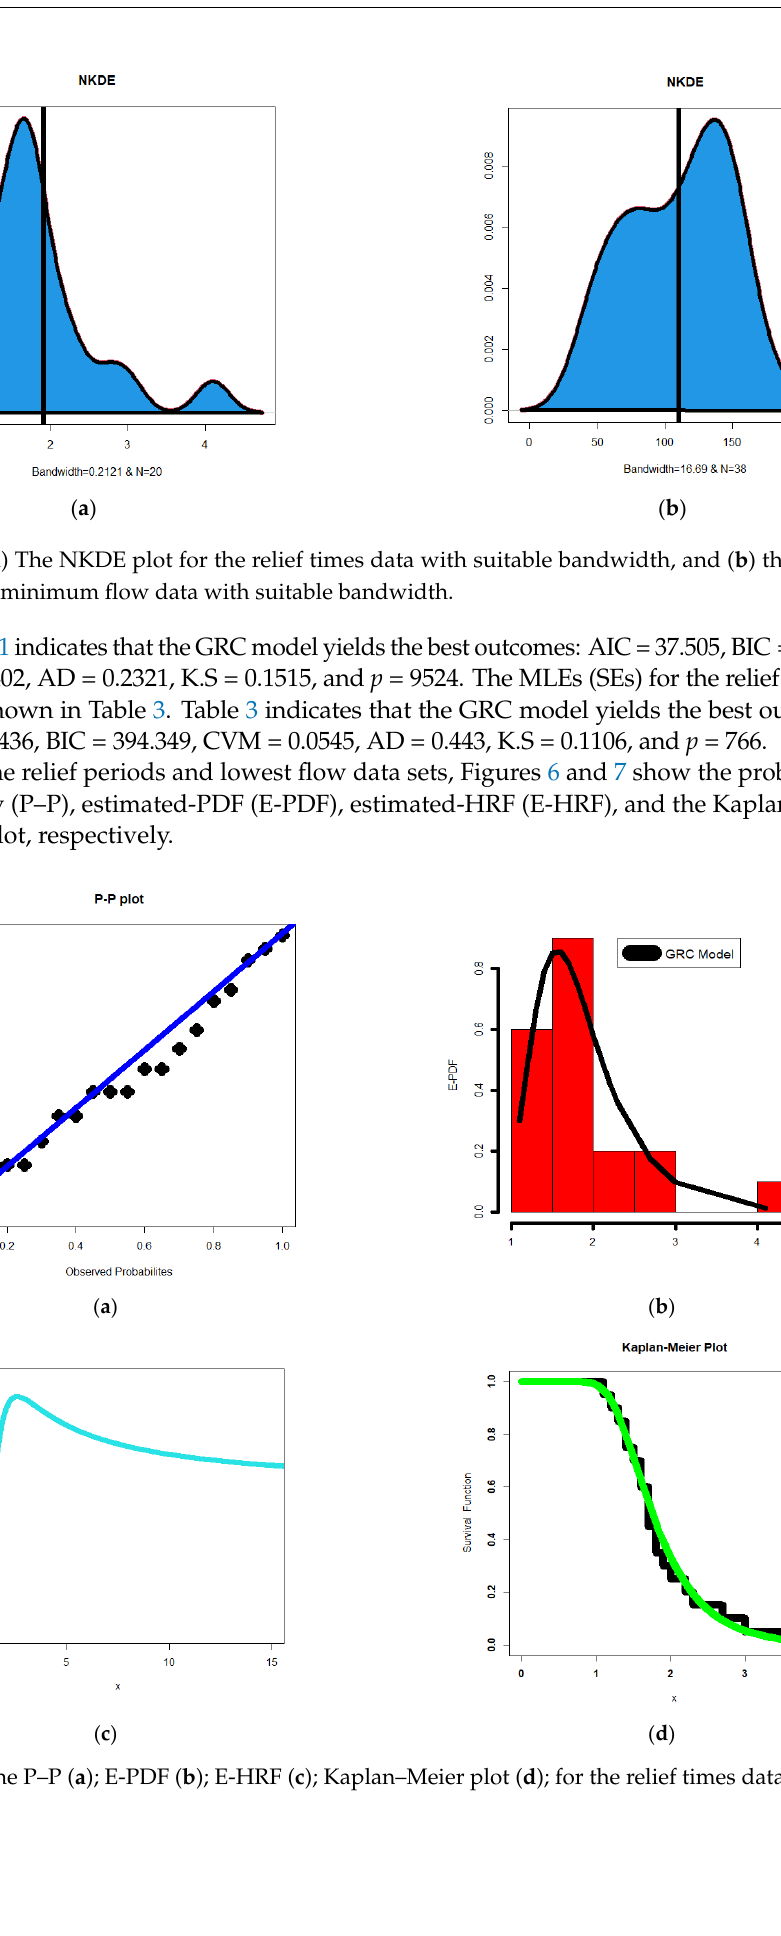
Figure 4. TTT plots.